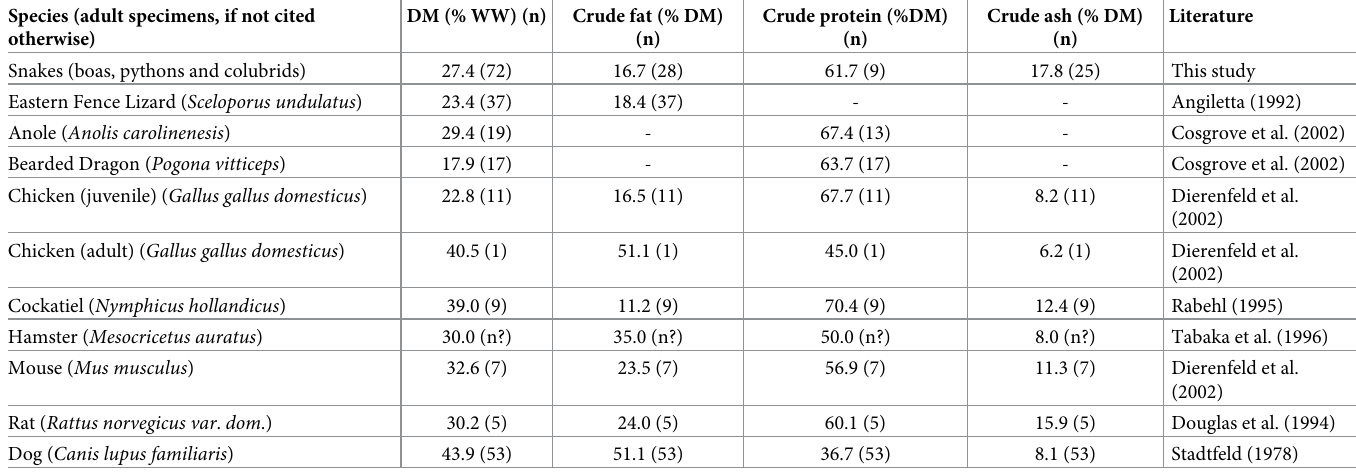
Table 8. Comparison of the whole-body DM and nutrient content of different reptilian, avian and mammalian species (n = number of observations). Species (adult specimens, if not cited